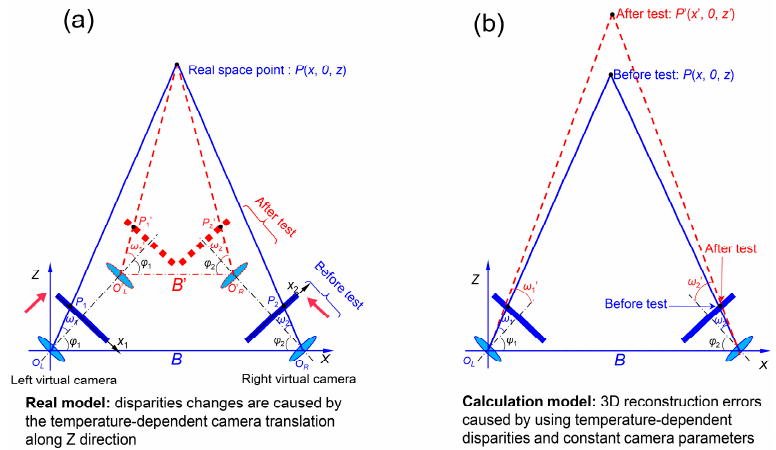
Figure 8. ( a ) A real model to explain how the disparities of the two projection points change during the test; ( b ) a calculation model to explain how the reconstruction errors are introduced during the calculation process.